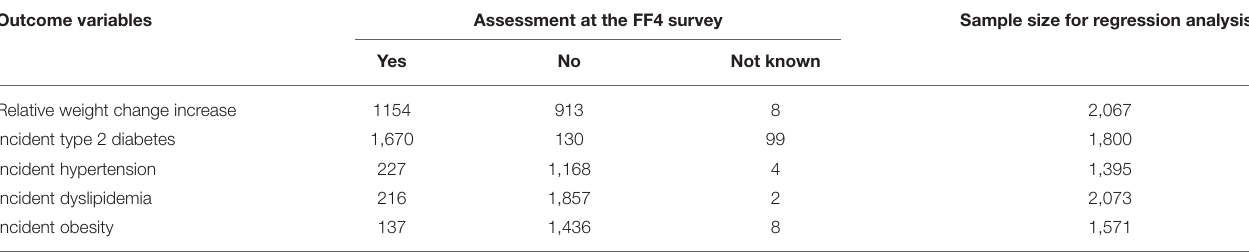
TABLE 3 | Metabolic diseases/risk factors defined as outcome variables and their frequencies in participants assessed at the FF4 survey. Outcome variables